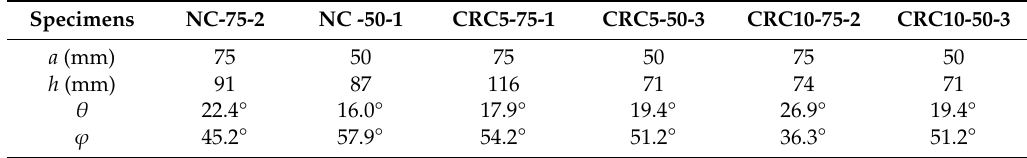
Figure 10. Failure wedges. Table 5. Summary of the geometry of failure wedges.